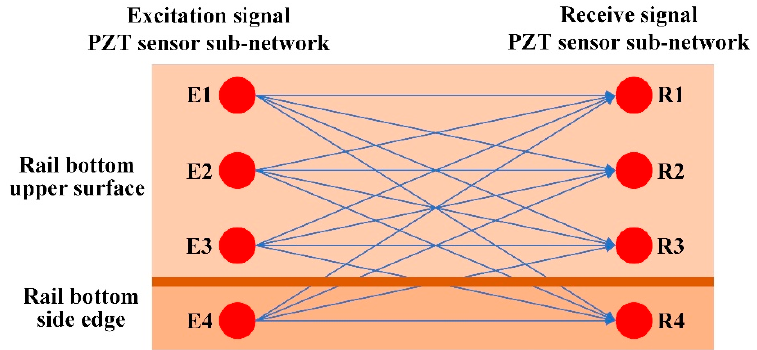
Figure 7. Schematic diagram of piezoelectric sensor arrays multipath monitoring.